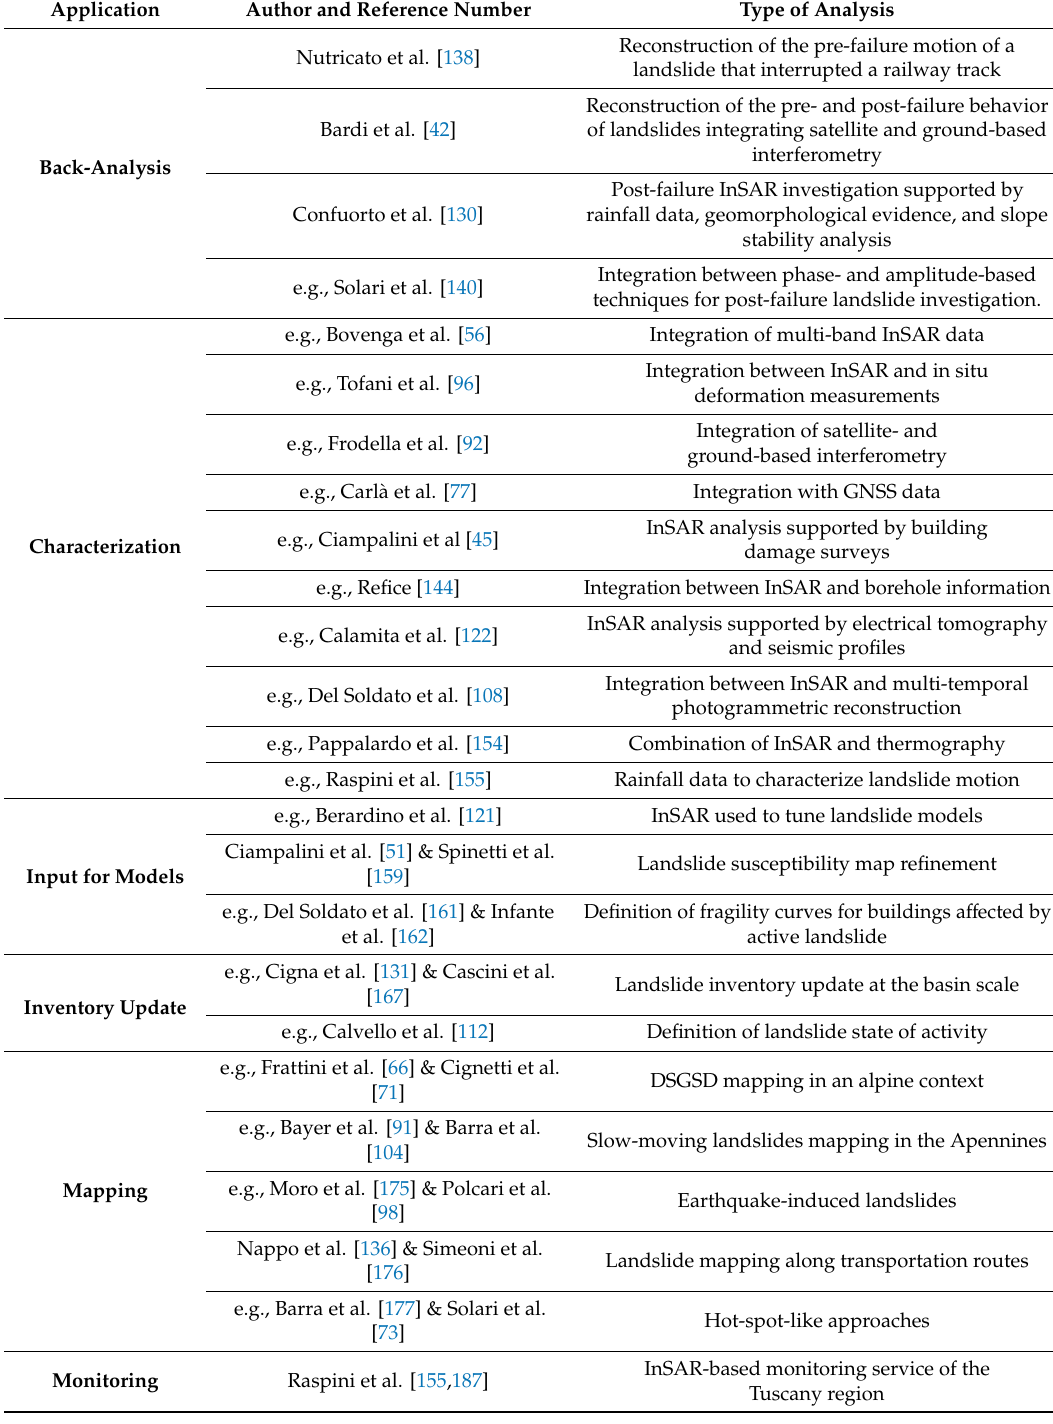
Table 1. Summary of the reference papers for each category of InSAR application. For the complete reference list, we refer to the six sub-sections of Chapter